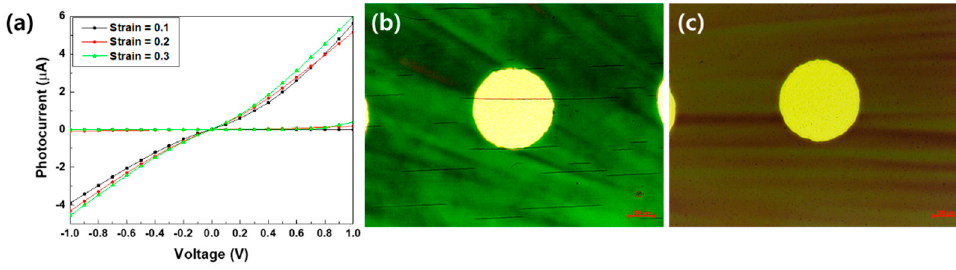
Figure 4. ( a ) Plot of photocurrent versus voltage for hybrid PD with PVDF-TrFE under different strain. Microscopy images of Al electrode side for hybrid PDs ( b ) without PVDF-TrFE and ( c ) with PVDF-TrFE after applying a strain of 0.3 under 100 bending cycles.